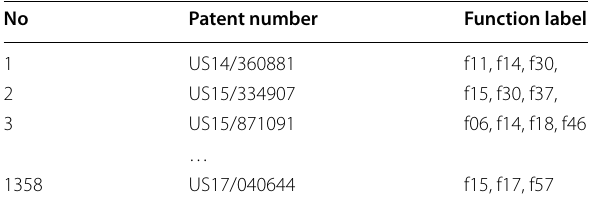
Table 3 Function labels of patents